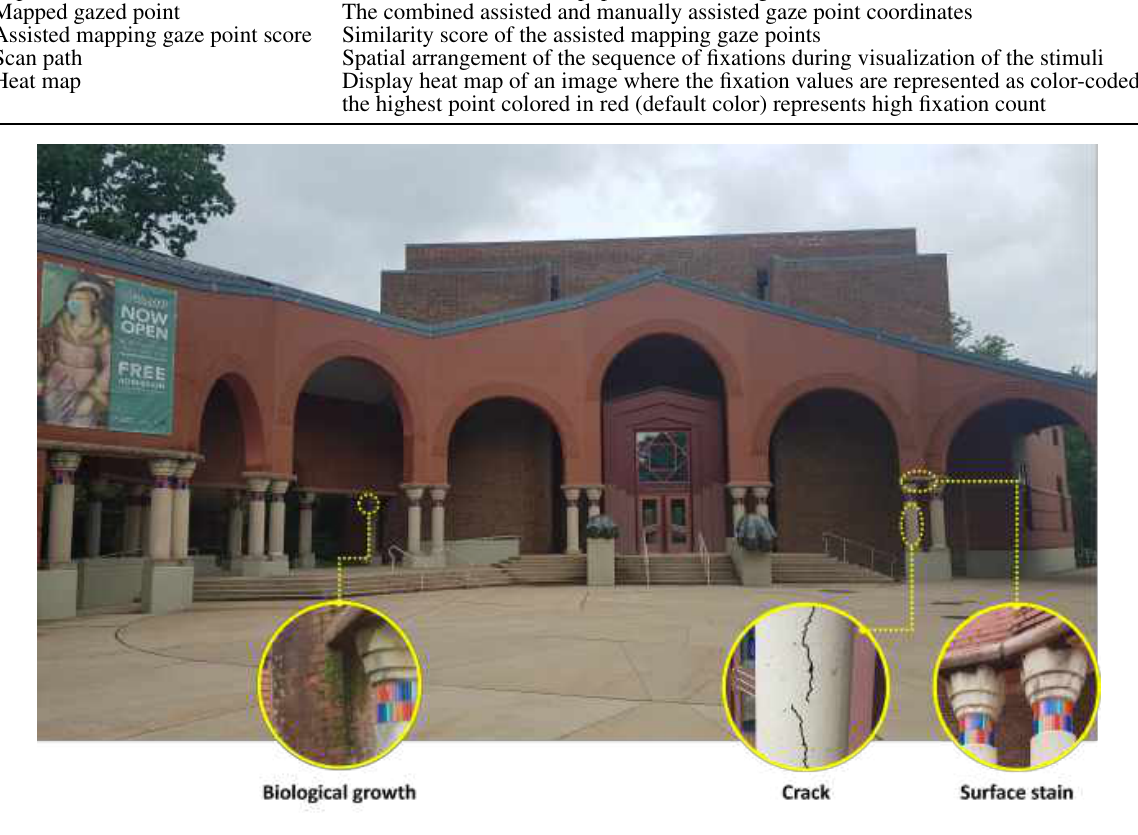
Figure 3. Palmer Museum of Art at University